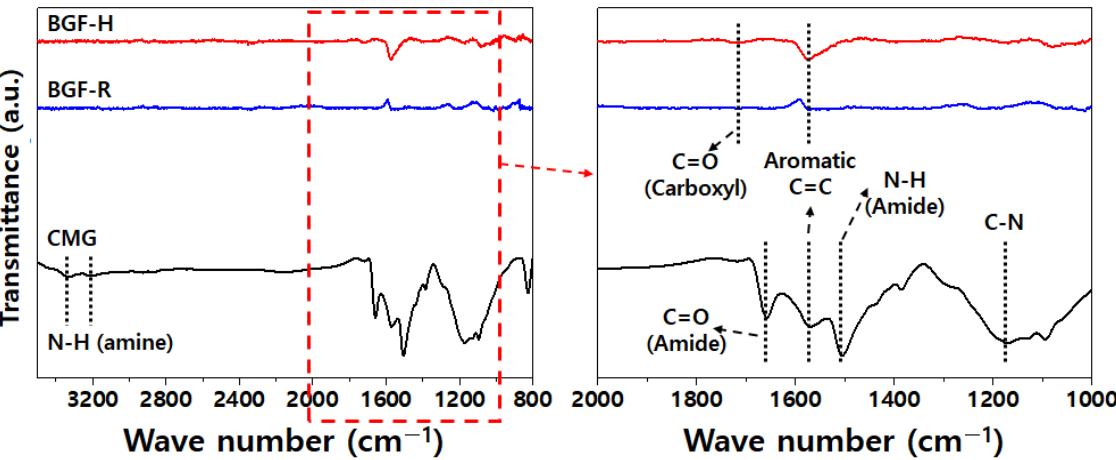
Figure 1. FT-IR spectra of graphene powder (BGF-H, BGF-R) and CMG.